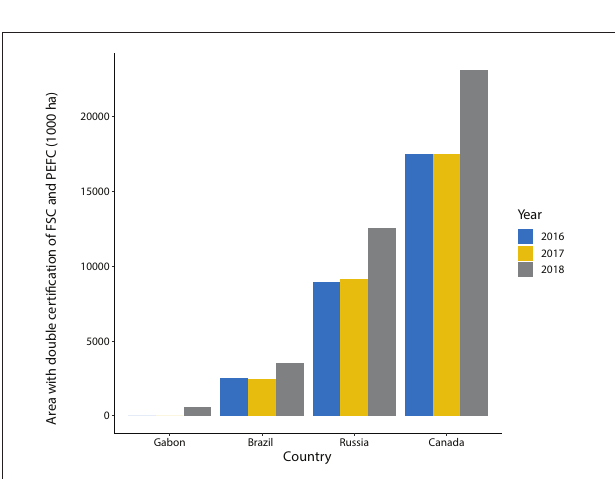
FIGURE 3 | Area (ha) with double certification by FSC and PEFC for countries with large IFL (sources: https://fsc.org/en/page/facts-figures, https://www. atibt.org/en/press-release-of-our-partner-pafc-gabon-the-forest-certification- pacf-gabon-continues-its-development-and-commitment-to-the-gabonese-